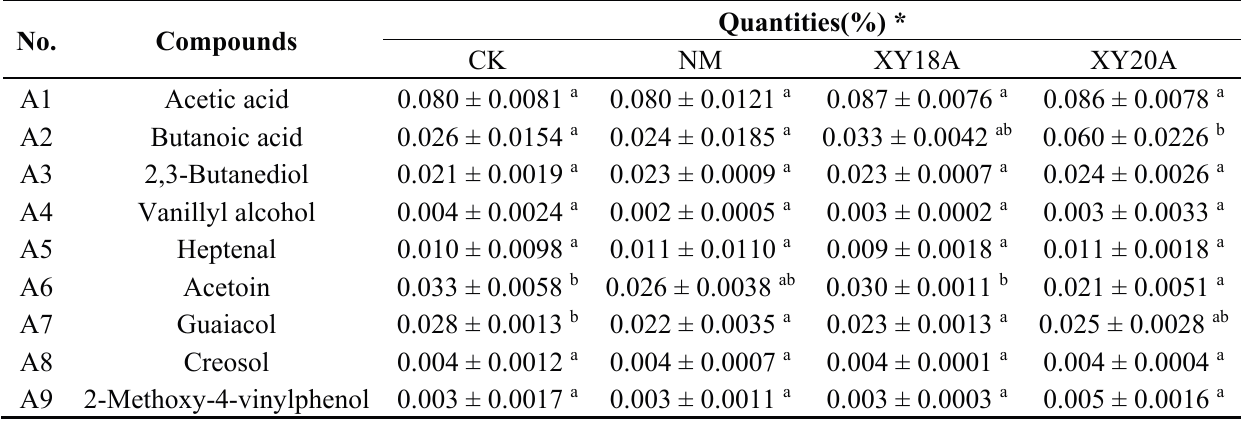
Table 2. Aroma compounds found in SPME extracts of four VF samples.